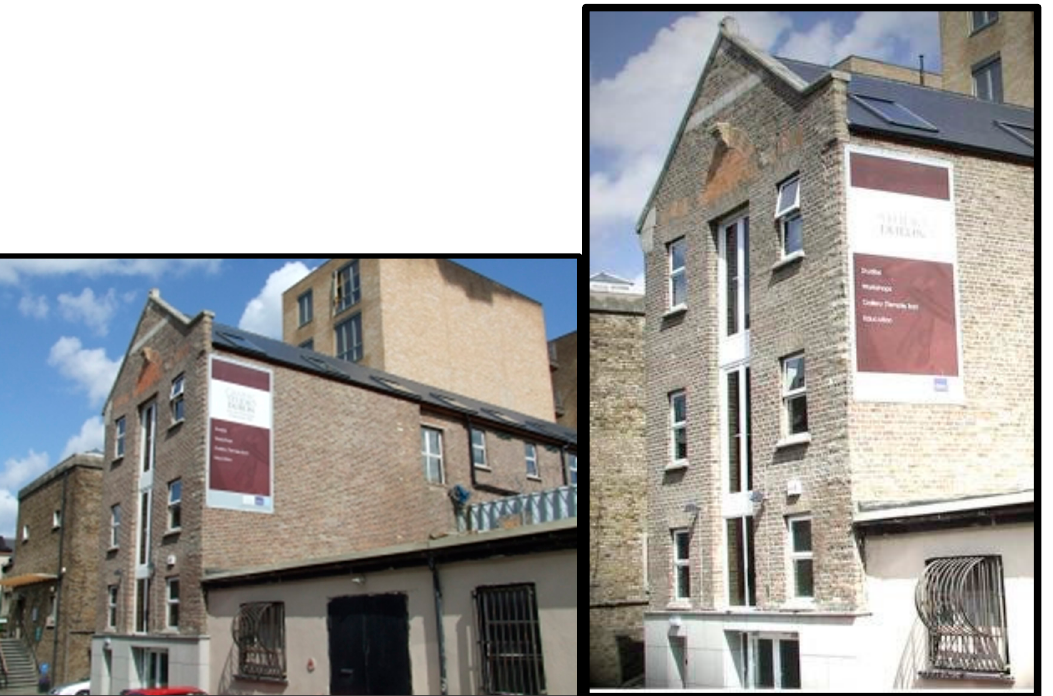
Figure 5. The four ‐ storey converted granary, new printmaking studio for GSD. Figure 5. The four-storey converted granary, new printmaking studio for